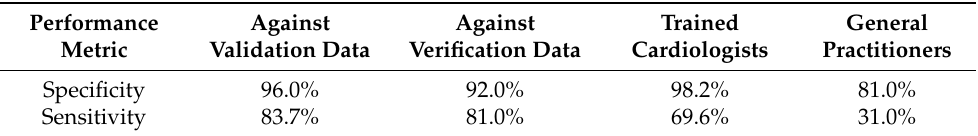
Table 3. Performance comparison of mobile application against validation/verification databases and medical staff.